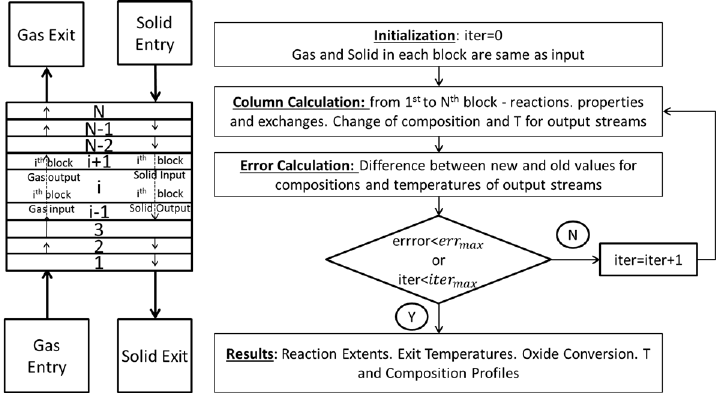
Figure A1. Resolution scheme for the reduction and transition zones.